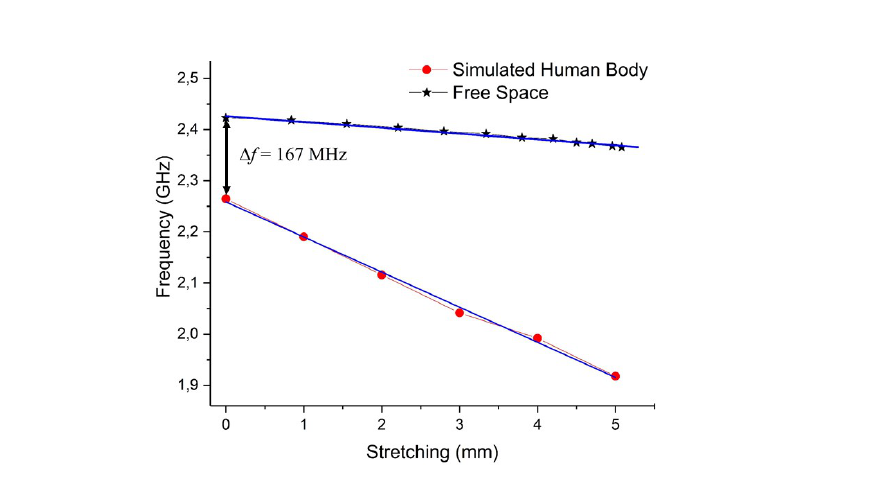
Figure 6. Resonant frequency shift of the textile-integrated spiral fiber antenna as a function of the induced stretch on the SHB and in free space.